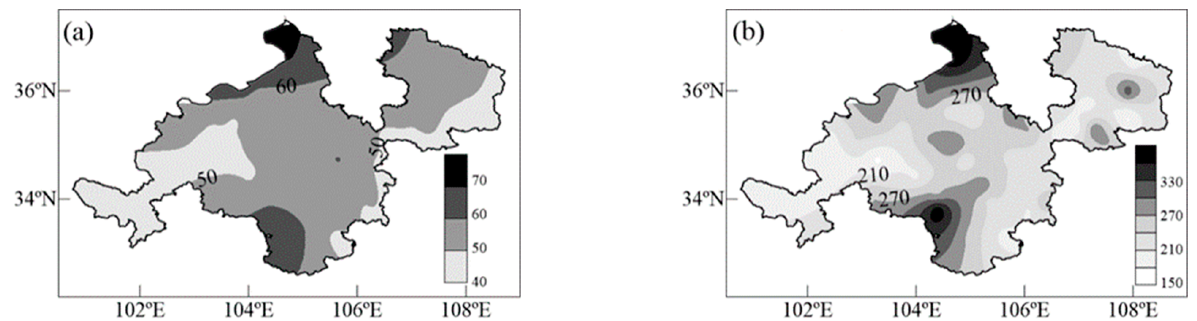
Figure 3. Average ( a ) and longest duration ( b ) of drought processes from 1960 to 2017 (days). As shown in Figure 4a, average drought intensity in 1960 to 2017 was high in the north-central regions ( − 75.8), followed by the southwestern and some south-central re- gions (approximately − 68). The maximum intensity of drought processes in the study area occurred in the central and eastern regions (Figure 4b). In the eastern areas, the most seri- ous drought process occurred from 10 March 1995 to 11 January 1996. The cumulative intensity of the drought process reached up to − 482.9 and lasted for 273 days. The second most serious drought occurred in the south-central region, from 1 June 1997 to 10 March 1998. The cumulative intensity was − 464.4, and the drought lasted for 280 days. Addition- ally, in some of the middle regions, a stronger drought with a cumulative intensity of − 430 to approximately − 440 also occurred. Figure 4. Average ( a ) and maximum intensity ( b ) of drought processes during 1960–2017. 3.1.2. Frequency of Different Types of Drought Processes To further understand the main periods and regions of the drought process, the oc- currence frequencies of different drought processes were determined. Spring drought re- fers to droughts confined to the months from March to May, while the spring-to-summer droughts are bounded by the months from March to August. The summer-to-autumn-to- winter drought spans two seasons from June of one year to February in the following year. Other drought types are similarly described. As shown in Figure 5, spring and summer droughts were the main types in the study area. The frequency of spring droughts was 24–58%, and they occurred approximately once every 3 years in most regions. In some of the north-central regions, the frequency was over 45%, and they occurred approximately once every 2 years (Figure 5a). The frequency of summer drought was 20–35%, and these occurred approximately once every 3–4 years. In the southeast and some of the middle regions, the frequency was slightly higher at once every 3 years (Figure 5b). Autumn droughts occurred with the least frequency among the four seasons (20.4% on average). Droughts occurred in the north-central and south-east regions slightly more often than in the other regions (25% to 30%, or approximately once every 4 years, Figure 5c). Winter droughts occurred with a frequency of 10–30%. The high-frequency region was located in the east-central region. There, the frequency was more than 25% and approximately once